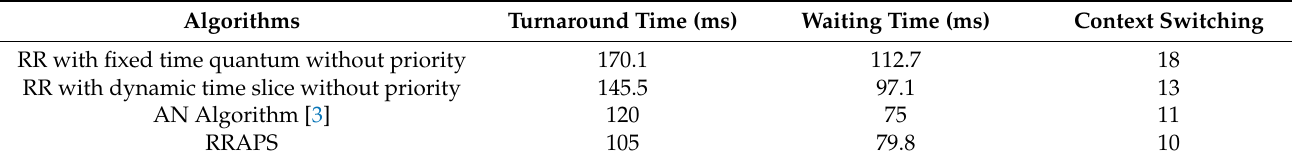
Table 4. Assessment of Case 4 results for different algorithm